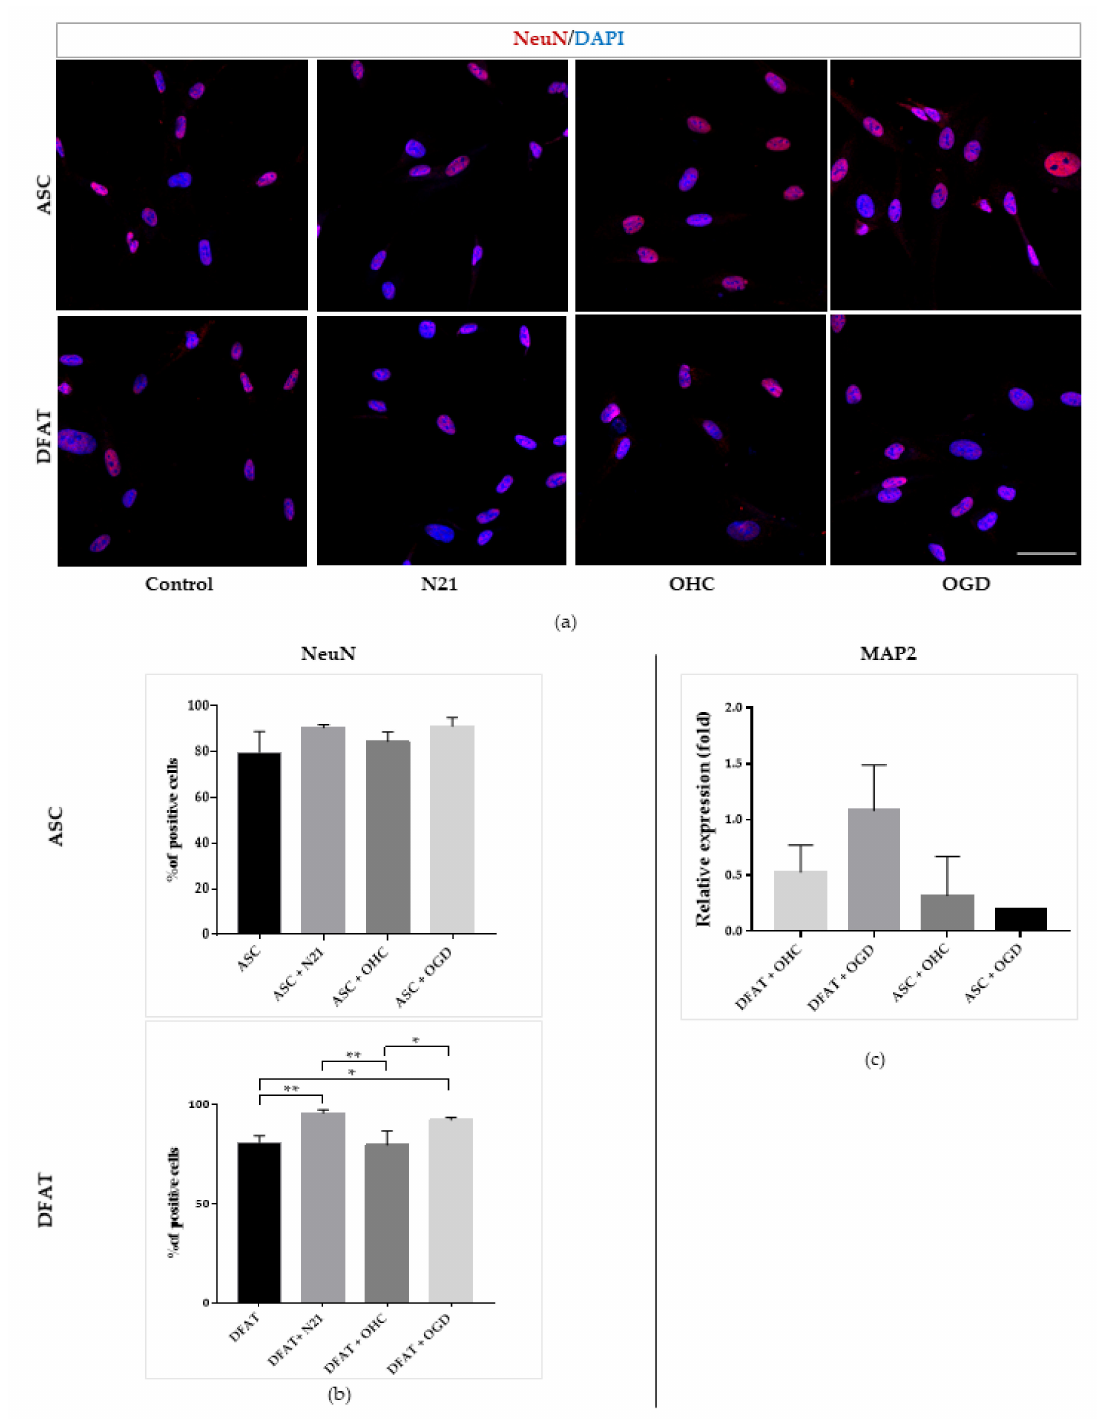
Figure 11. Neuronal differentiation of ASCs/DFAT cells. NeuN, MAP2 immunocytochemical/expression analysis. ( a ) Im- munofluorescent images of ASCs/DFAT cells NeuN staining; ( b ) Quantitative analysis of neuronal marker NeuN presence in different culture conditions; ( c ) Neuronal marker MAP2 expression. The results are presented as mean values of three experiments ± SEM. The differences were considered statistically significant when p -value <0.05. Statistical significance level * for 0.01 < p <0.05; ** for 0.001 < p < 0.01; *** for 0.0001 < p < 0.001; **** for p <